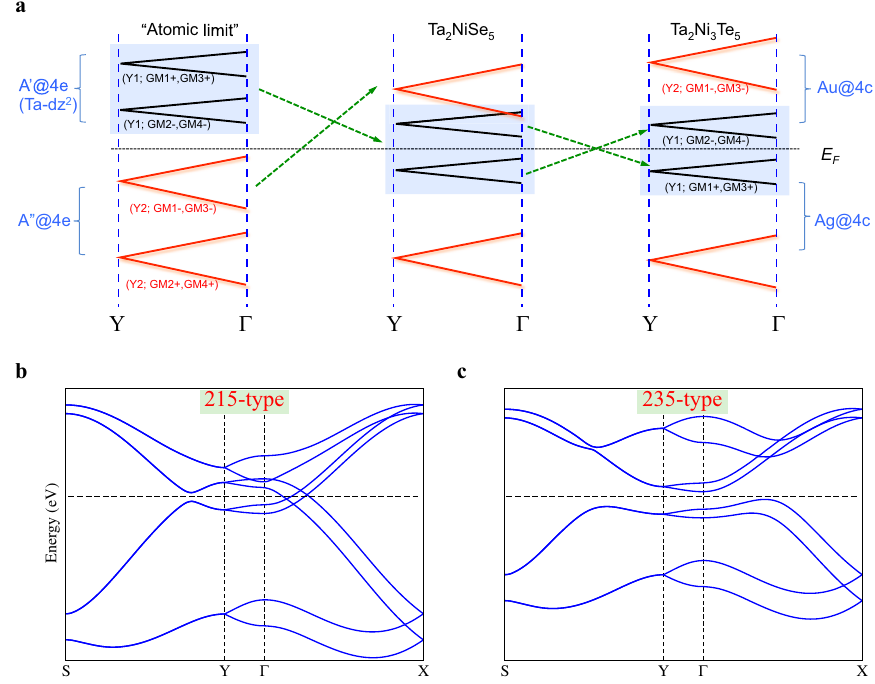
Fig. 2 The double-band inversion process. a The diagram of double-band inversion along Y – Γ line. The schematic band structures of ( b ) 215- type semimetal and ( c ) 235-type insulator. The double-band inversion happens in both cases. The crossing points on the Γ – X line are part of the nodal